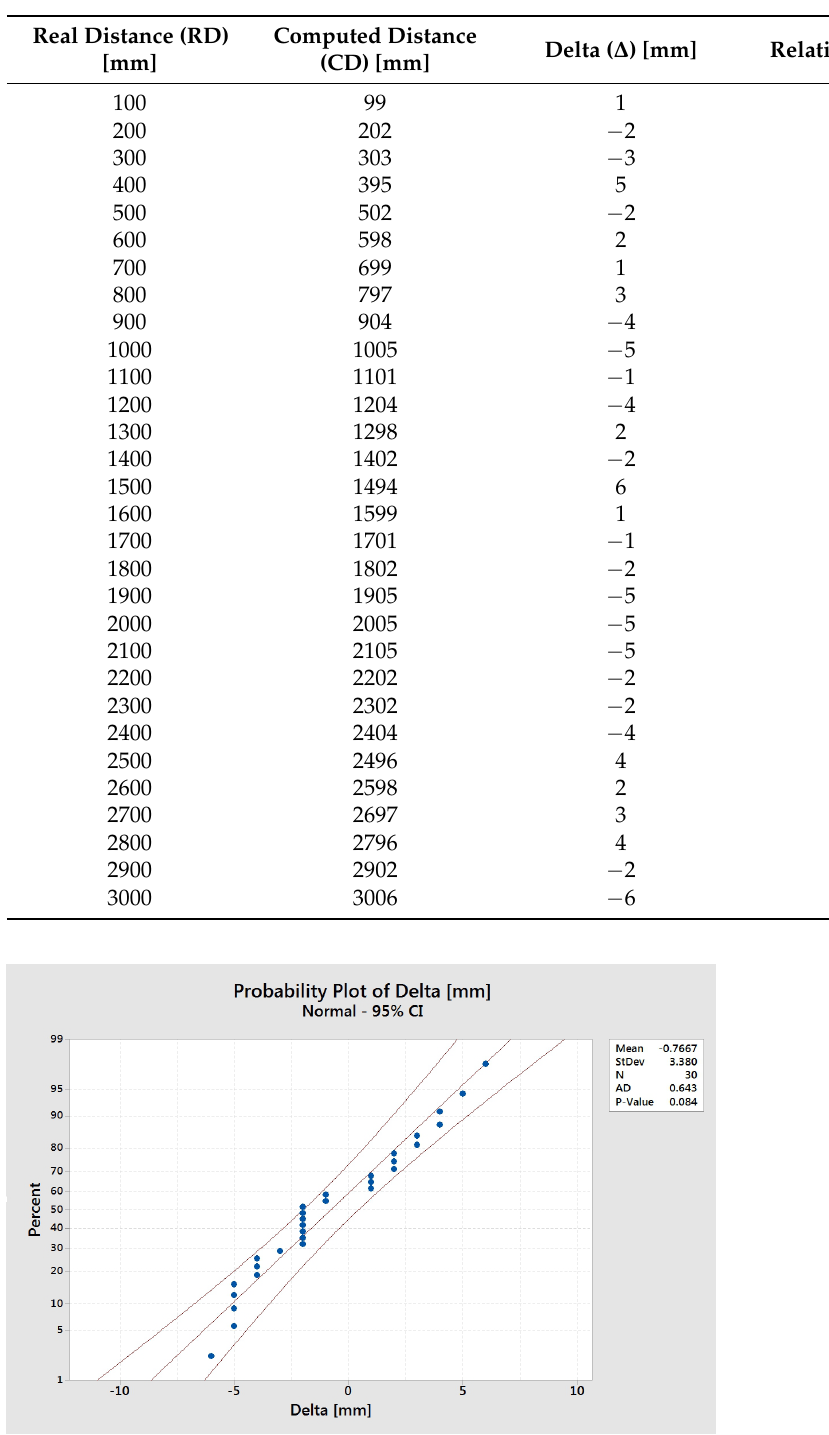
Table 2. Distance measurement using video cameras at different distances in [mm] with a highlight on the measurement delta (error) in [mm] and the relative error.